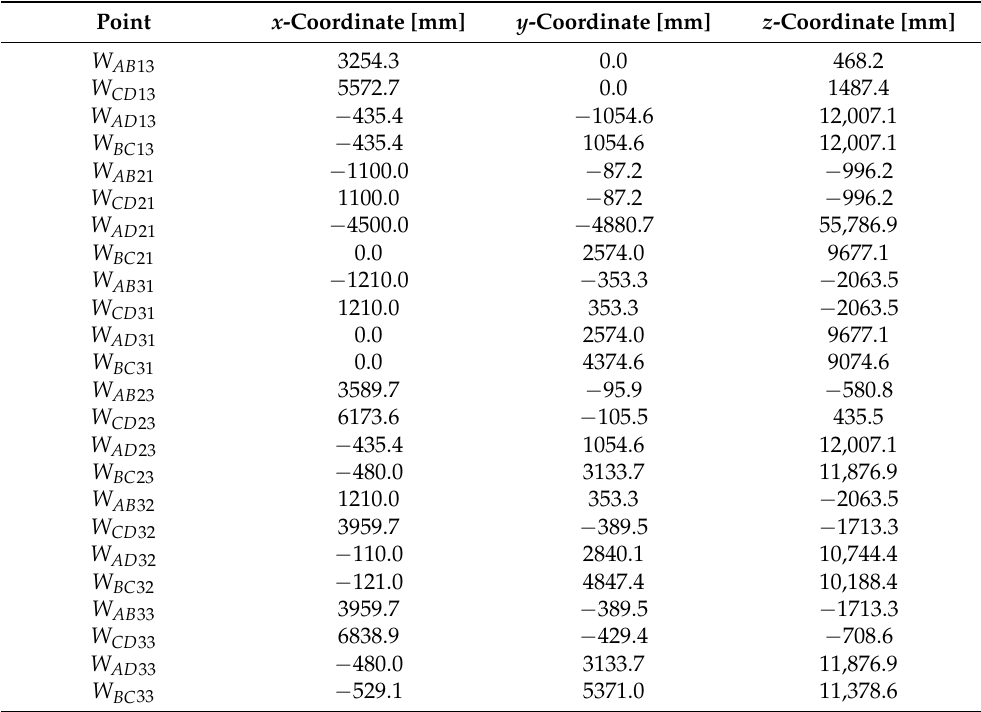
Table A1. The coordinates of the vertices W ABij , W CDij , W ADij , W BCij (for i, j = 1, 2, 3) of the polyhedral